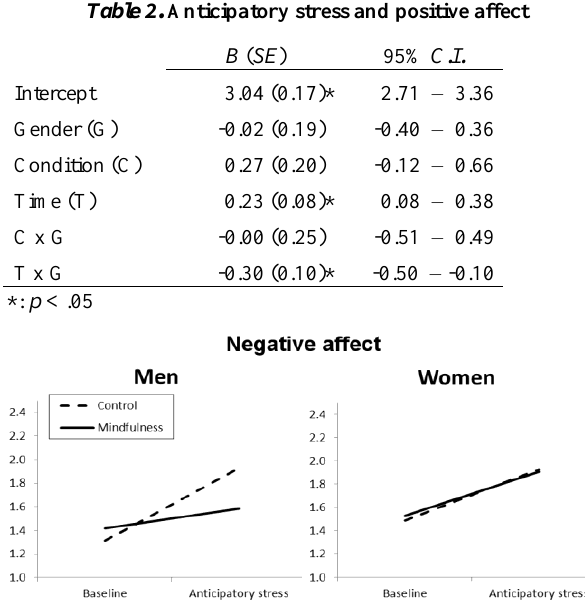
Figure 1. Anticipatory stress and negative affect (interaction